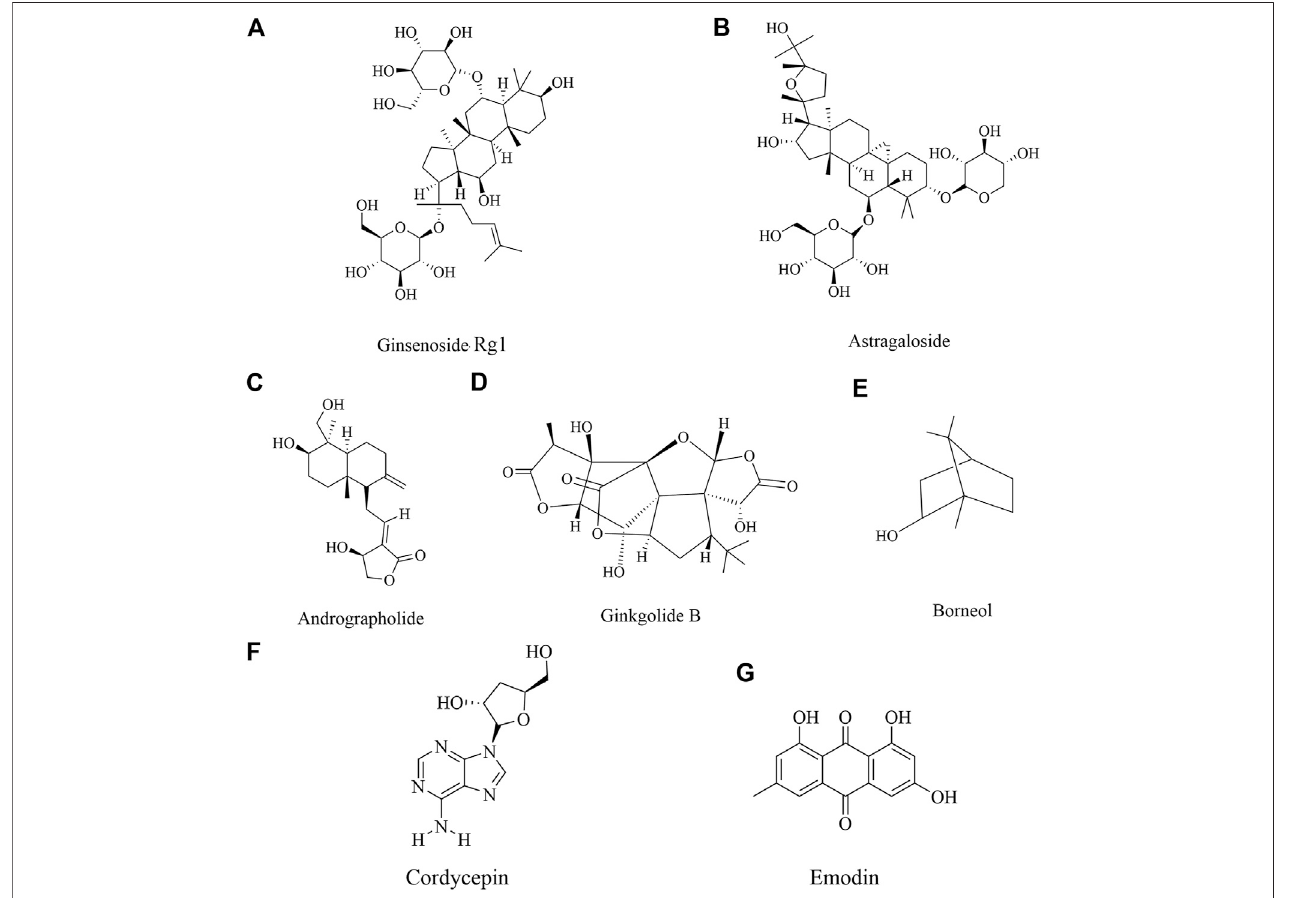
FIGURE 5 | The saponin, terpenoids and others for cerebral ischemia